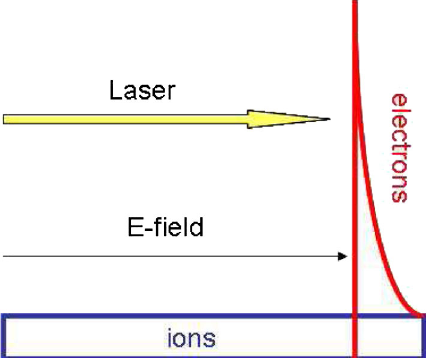
FIG. 3. Schematic drawing of electron and ion densities after some femtoseconds of laser irradiation for radiation pressure acceleration (RPA). Compression of electrons by radiation pres- sure occurs until balance with the charge separation electric field is reached, which accelerates foil ions as a whole.